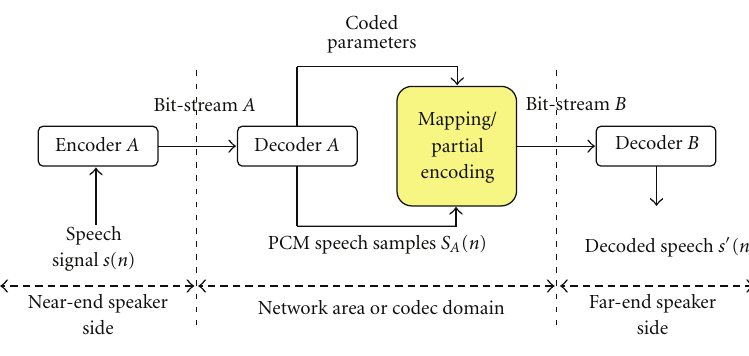
Figure 1: The smart transcoding